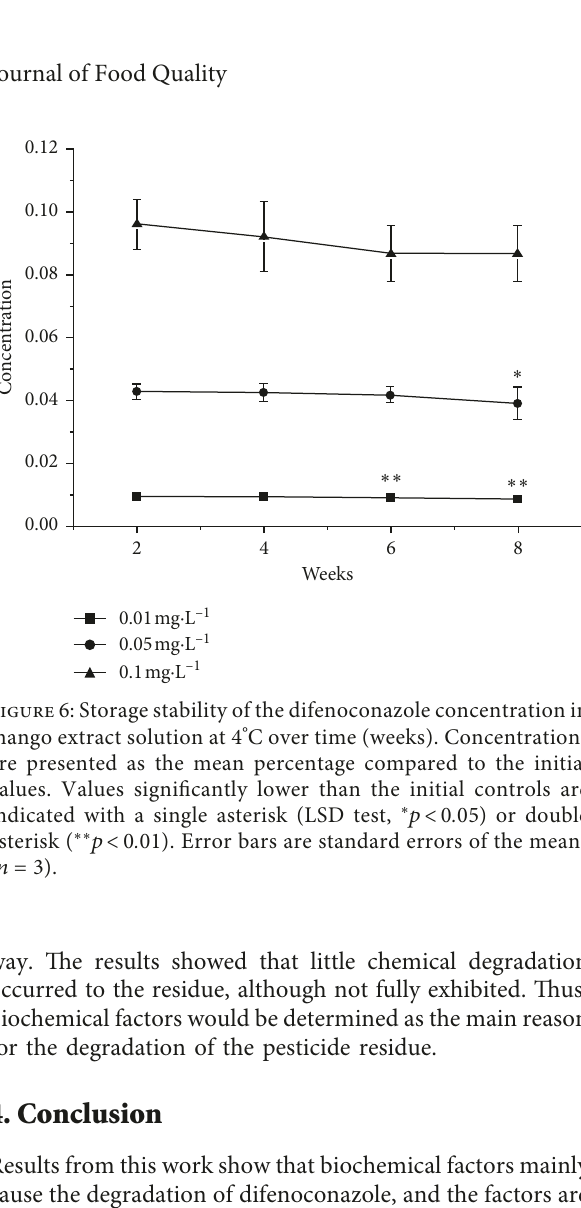
p 0 . 05) or double ∗ <